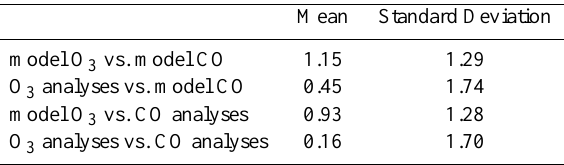
Table 2. Heights of the mean, median and standard deviation of the ExTL distribution in relative altitude space (km) for the different experiments. Negative mean values and positive mean values are below and above the thermal tropopause,